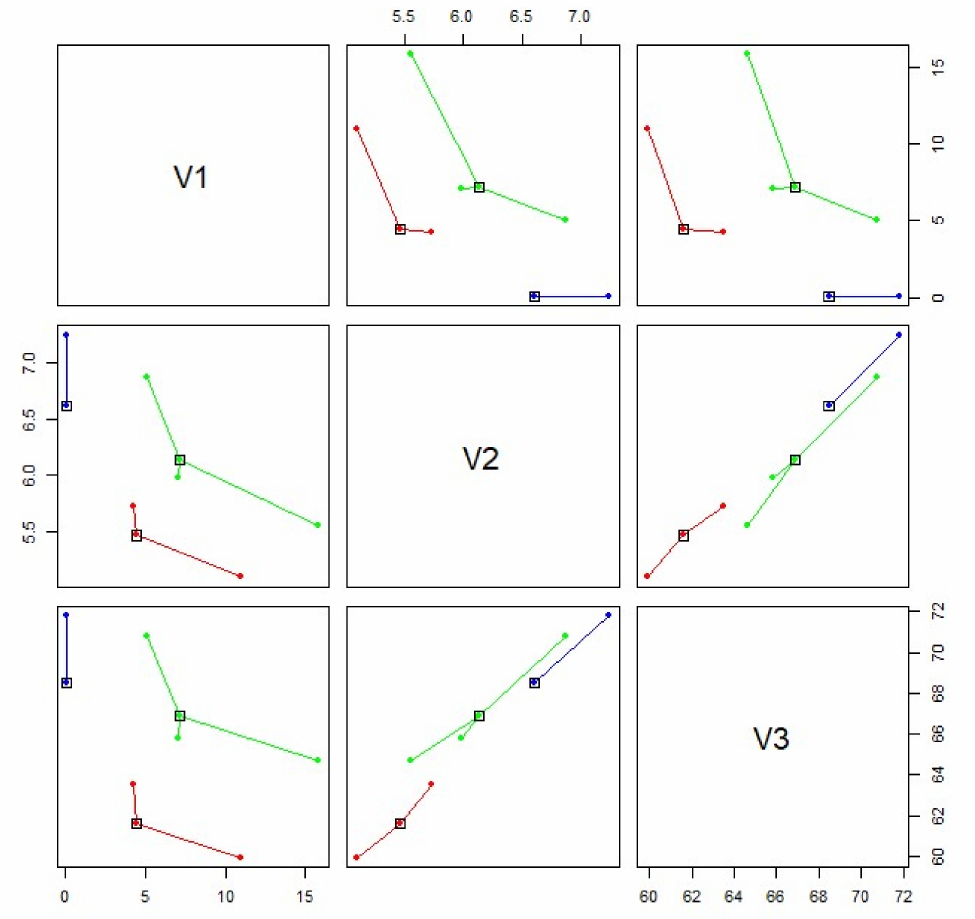
Figure 3. Clustering result for two-response combinations (three-cluster scheme) of the three water quality indices (V1 = removed Na + , V2 = SAR, V3 = Na +